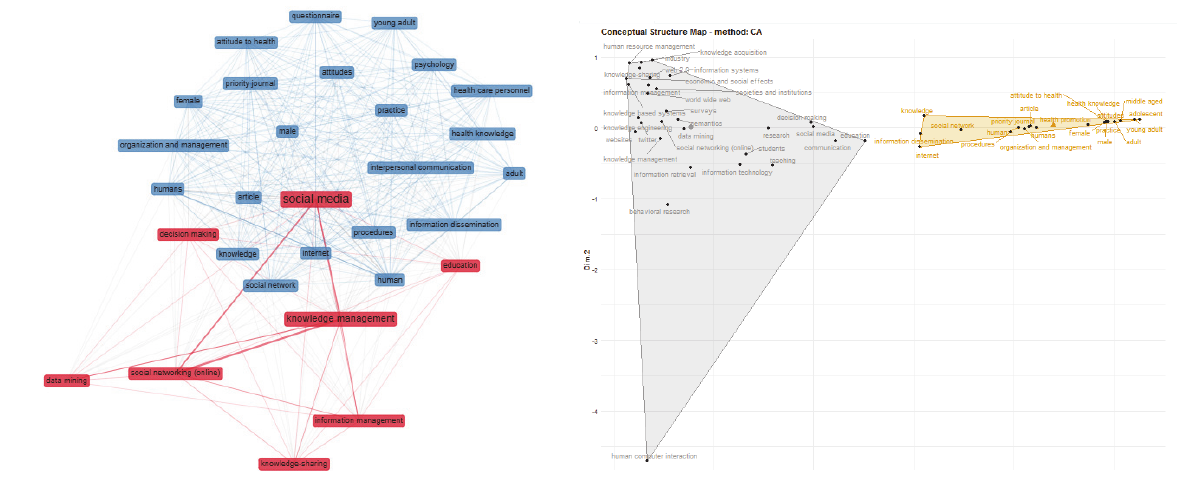
Fig. 4. Co-occurrence network (2011-2019) Fig. 5. Conceptual structure Map, method: CA